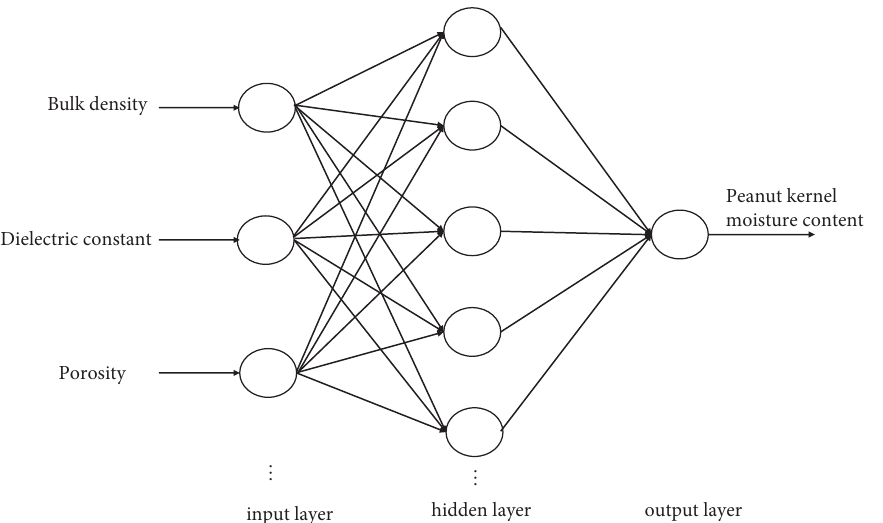
Figure 4: Extreme learning machine network